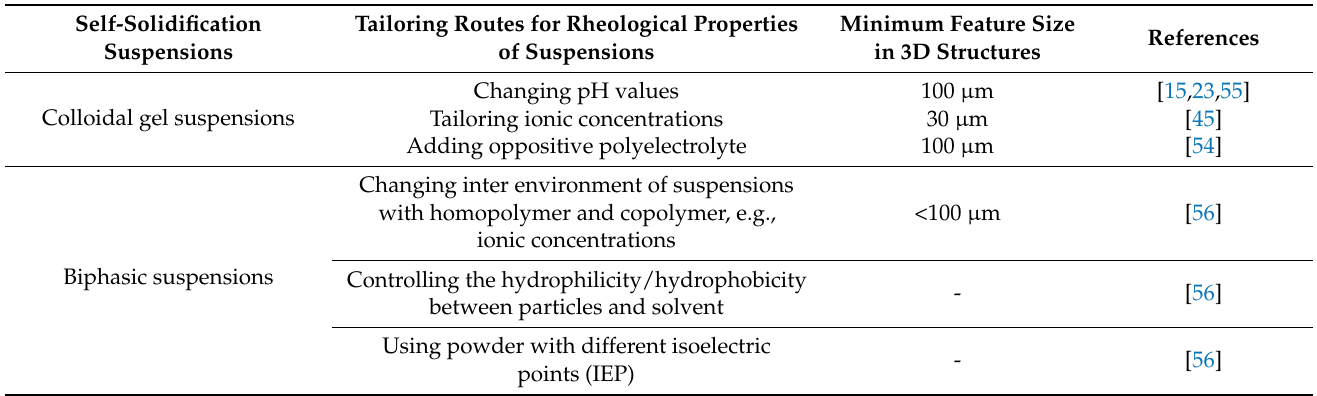
Table 1. Self-solidification suspensions designed for direct ink writing